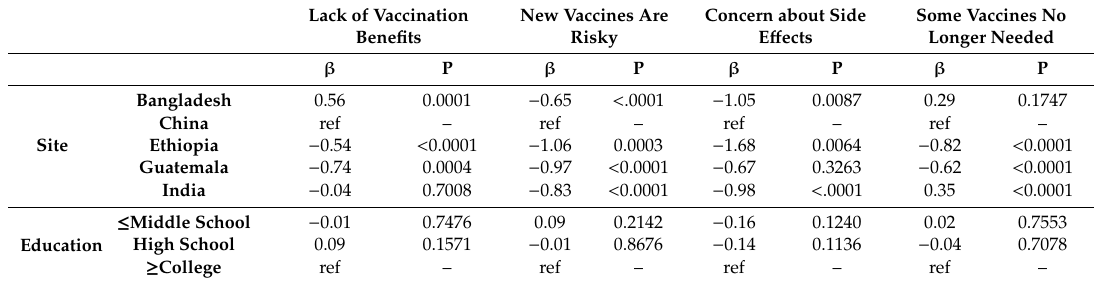
Table 5. Results of linear models with generalized estimating equations for vaccine hesitancy constructs, clustering by country as well as sub-national clustering from each survey’s study design. Lack of Vaccination New Vaccines Are Concern about Side Some Vaccines No Benefits Risky E ff ects Longer